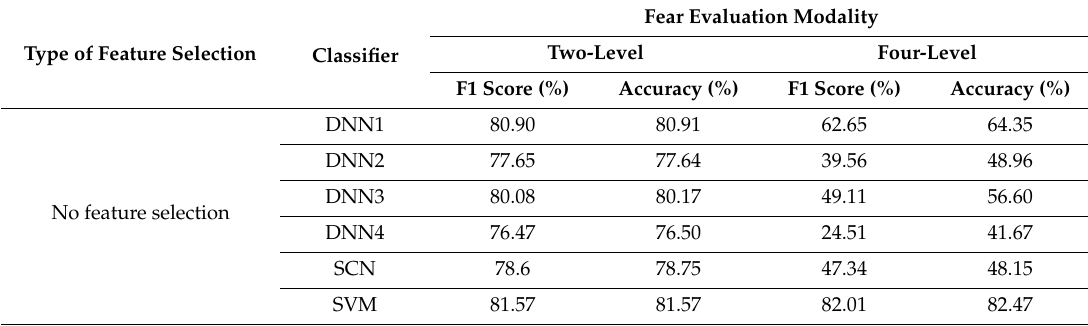
Table 5. Classification accuracy when input is a vector of 32 Petrosian Fractal Dimensions and eight peripheral signals. (The highest accuracies are written with